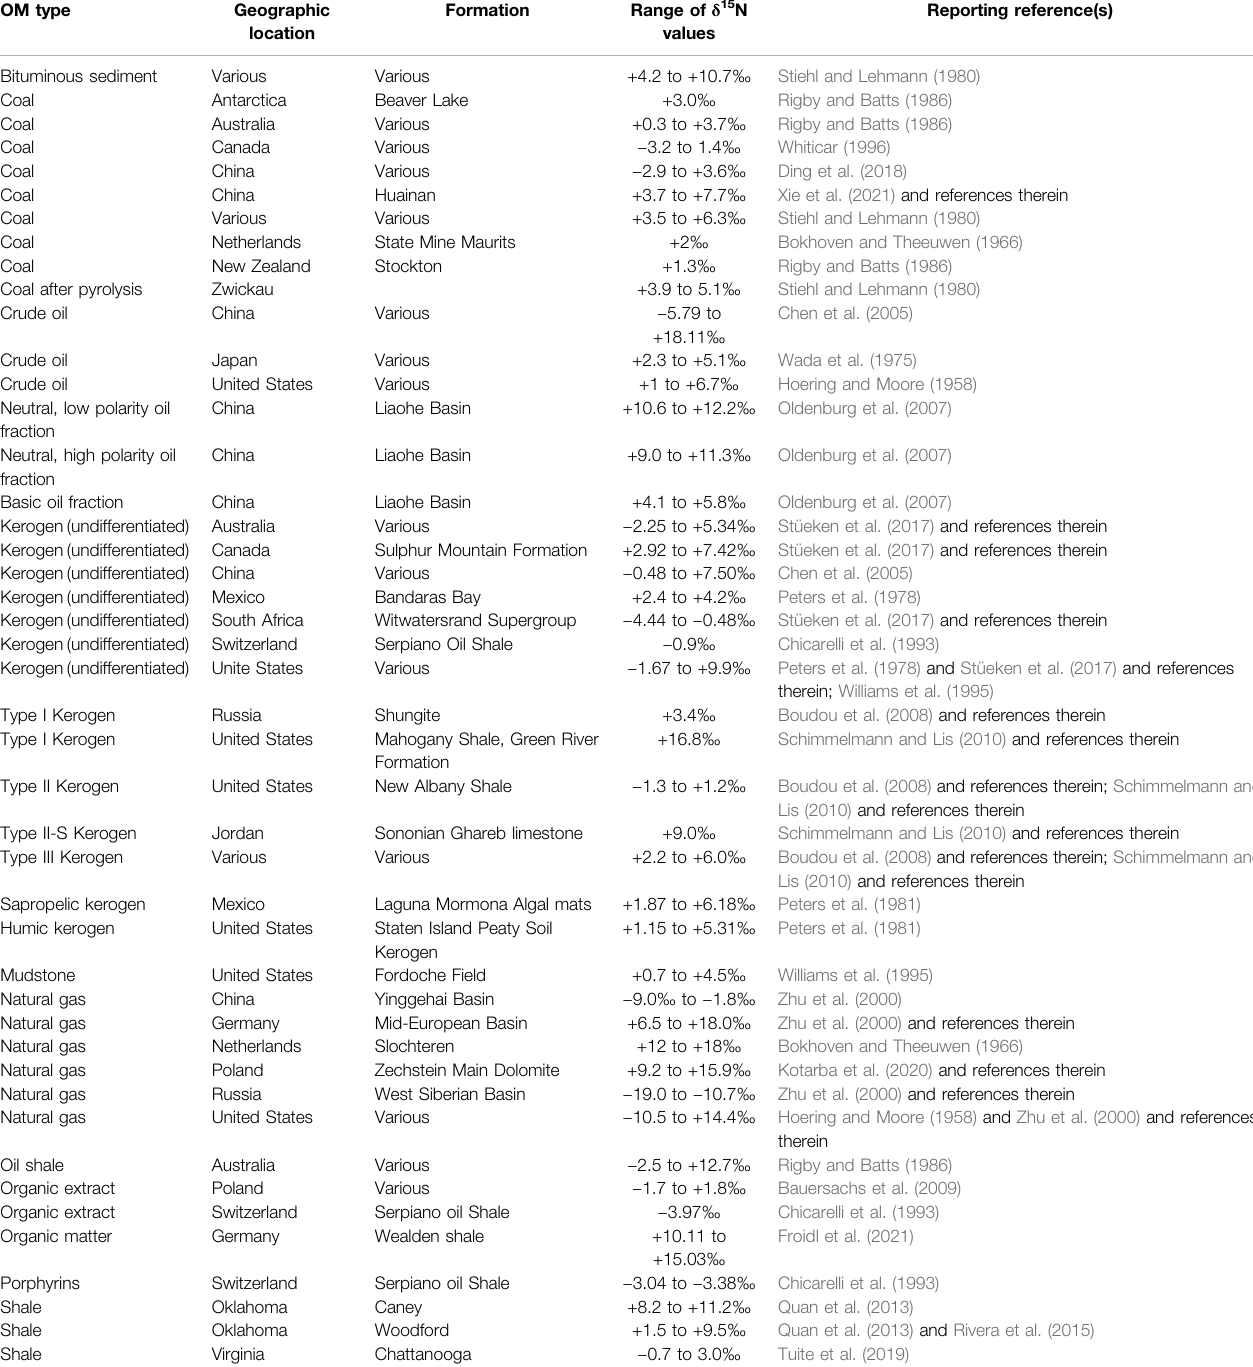
TABLE 1 | List of previously published δ 15 N values for a representative range of petroleum systems and petroleum-related samples. OM